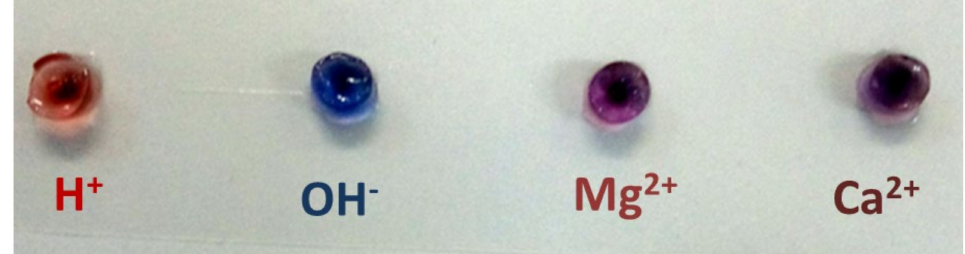
Figure 8. Photographs of PNIPAM gels loaded with a complexing agent (EBT), then dried and swollen to equilibrium in: acid media (H + , pH = 1), basic media (OH − , pH = 9), Mg 2+ solution (1 mM, pH = 9), Ca 2+ solution (1 mM, pH =